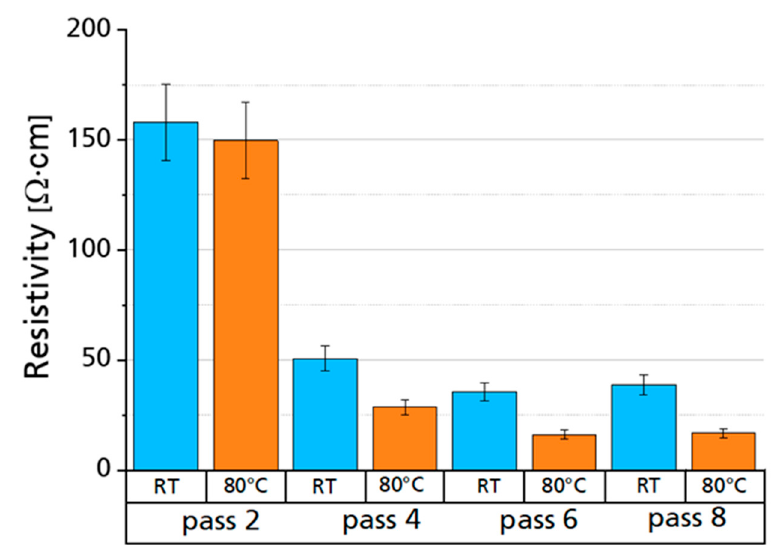
Figure 5. SWCNT/epoxy 0.1 wt.%—influence of curing temperature on electrical resistivity at different passes.